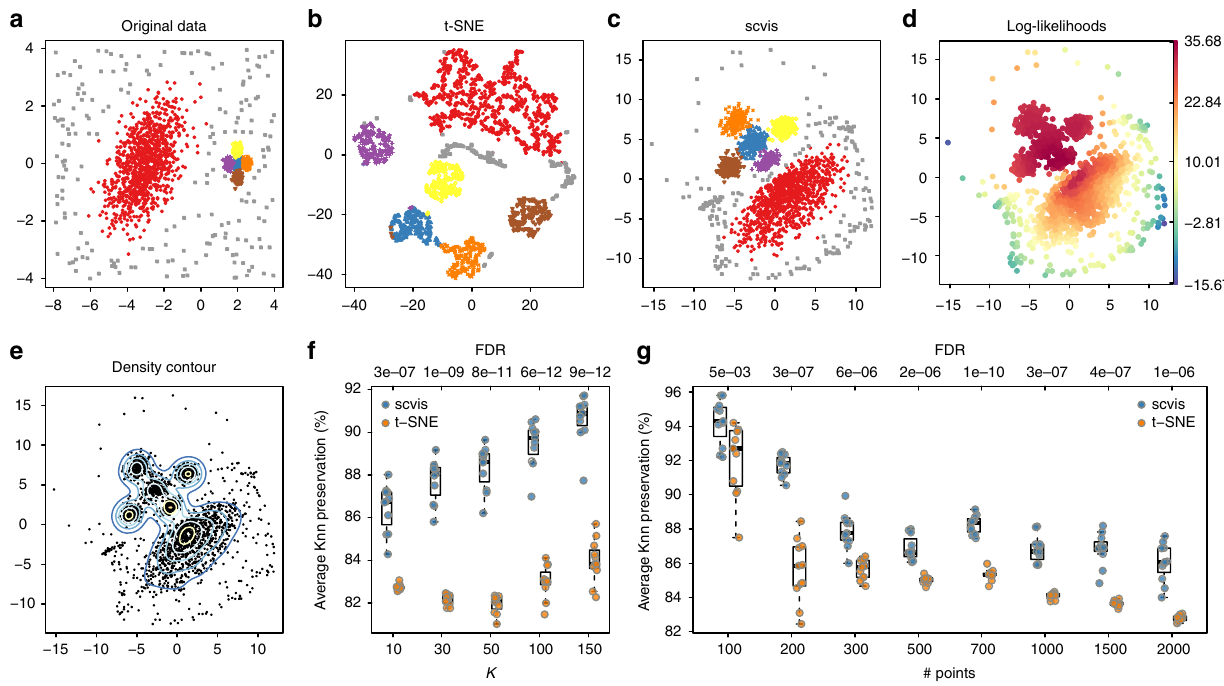
Fig. 2 Benchmarking scvis against t-SNE on synthetic data. a The original 2200 two-dimensional synthetic data points (points are colored by cluster labels. The randomly distributed outliers are also colored in a distinct color, same for b , c ), b t-SNE results on the transformed nine-dimensional dataset with default perplexity parameter of 30, c scvis results, d coloring points based on their log-likelihoods from scvis, e the kernel density estimates of the scvis results, where the density contours are represented by lines, f average K -nearest neighbor preservations across ten runs for different K s, and g the average K -nearest neighbor preservations ( K = 10) for different numbers of subsampled data points from ten repeated runs. The numbers at the top are the adjusted p -values (FDR, one-sided Welch ’ s t -test) comparing the average K nn preservations from scvis with those from t-SNE. Boxplots in f , g denote the medians and the interquartile ranges (IQRs). The whiskers of a boxplot are the lowest datum still within 1.5 IQR of the lower quartile and the highest datum still within 1.5 IQR of the upper